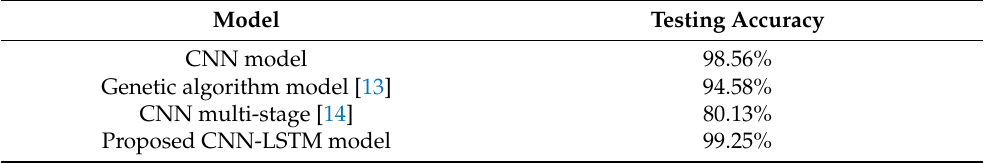
Table 7. Accuracy comparison between proposed model and other